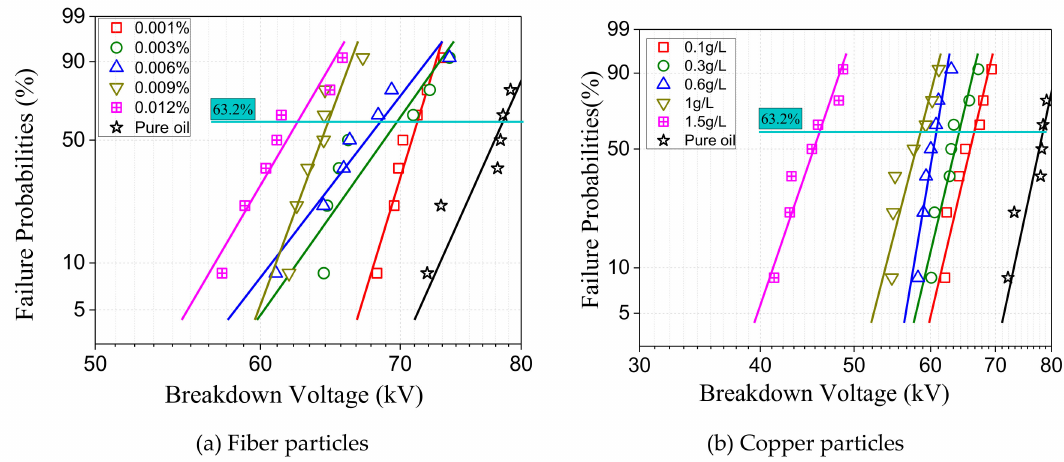
Figure 10. Weibull distribution of breakdown voltage for contaminated natural